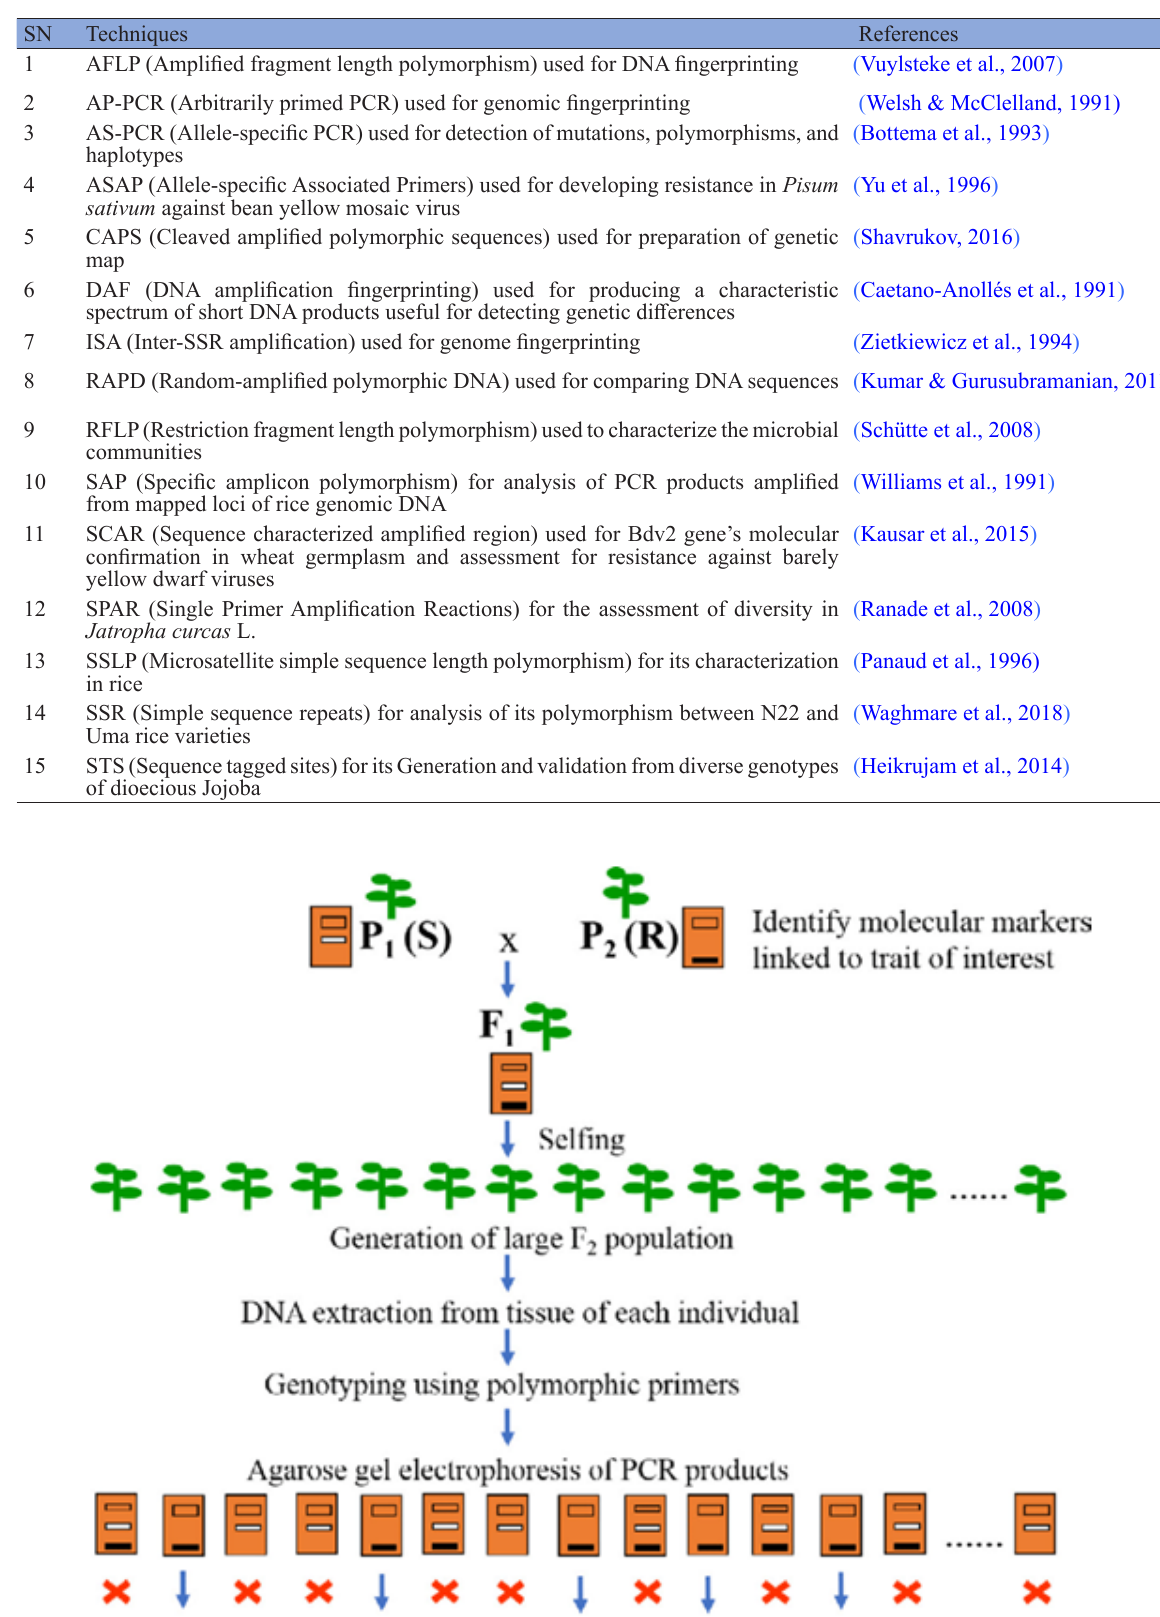
Table 1 Different Molecular Marker Techniques